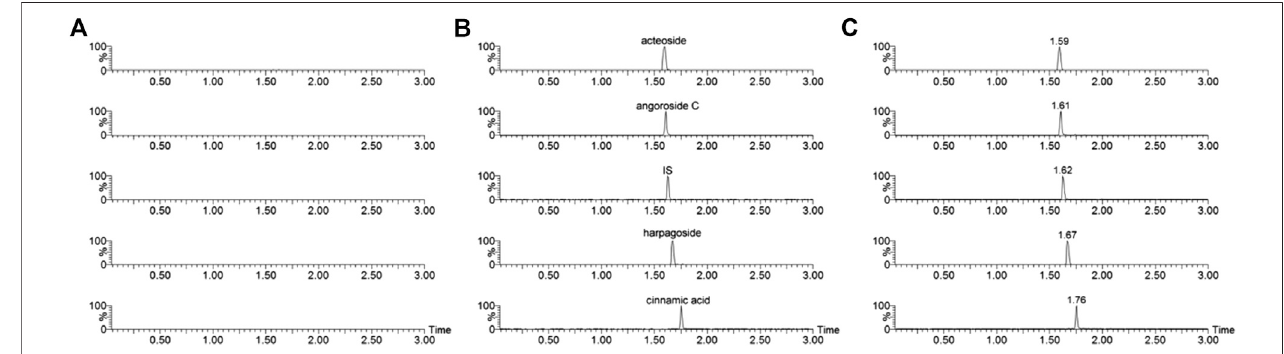
FIGURE2| Representativechromatogramsofacteoside, angoroside C,harpagoside,cinnamic acidand ISinratplasmasamples. (A) ablank plasmasample; (B) blank plasma sample spiked with acteoside, angoroside C, harpagoside, cinnamic acid and IS; (C) a rat plasma sample taken 0.25 h after sublingual intravenous administration of mixtures containing acteoside, angoroside C, harpagoside and cinnamic acid (3.0 mg/kg) in rats.